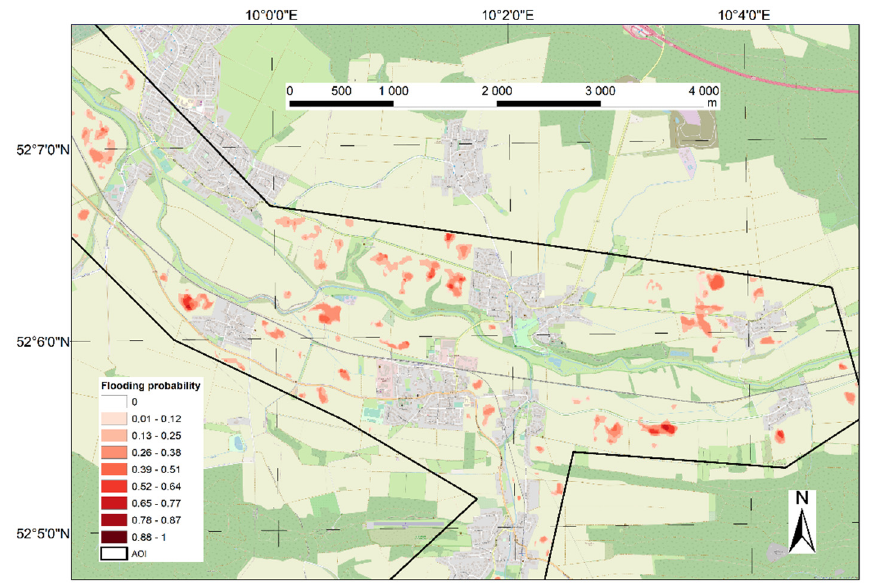
Figure 6. False-positive flood detection in part of sub-area 2 from Sentinel-1 images in track A117 acquired on 24 May 2017. Flooded areas are shown in red. Source of background map: Open Street Map (OSM).